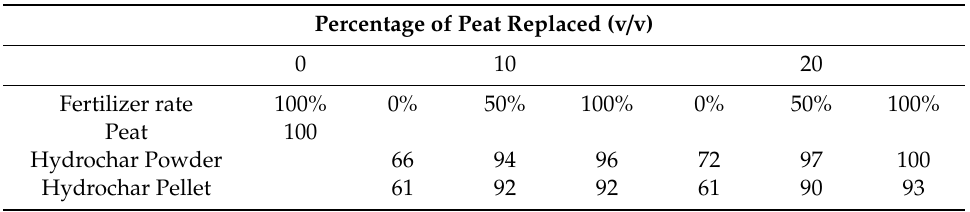
Table A1. Irrigation frequency for 6 months-old pine tree seedlings grown with 10% and 20% hydrochar powder and pellet standardized with values of control pines (without hydrochar) with 100%